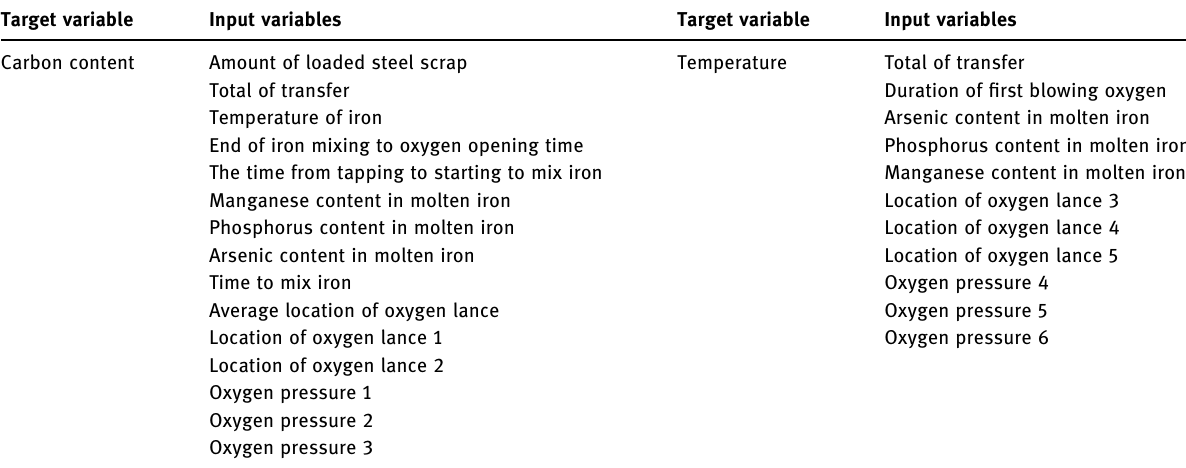
Table 3: The description of input variables